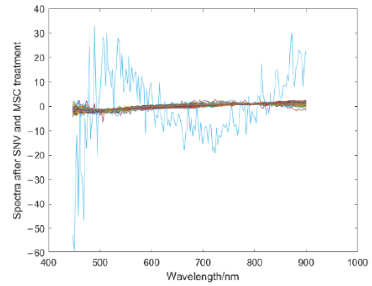
Figure 4. ( a ) Original spectrum of corn kernel mildew (400–1000 nm), and ( b ) spectrum of corn kernel mildew after removal of noisy bands (450–900 nm).